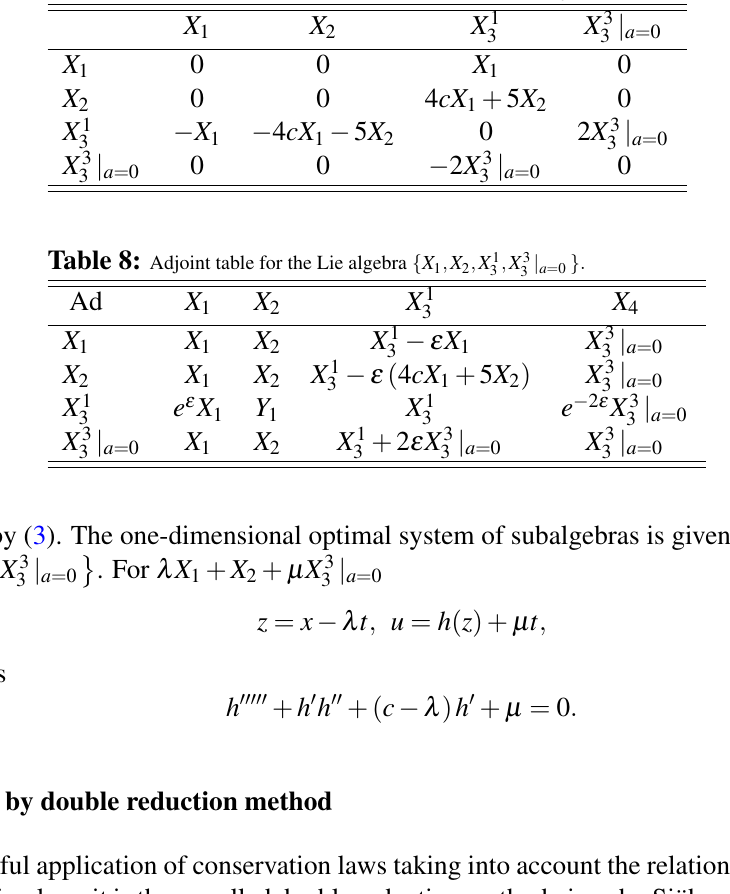
Table 7: Commutator table for the Lie algebra { X